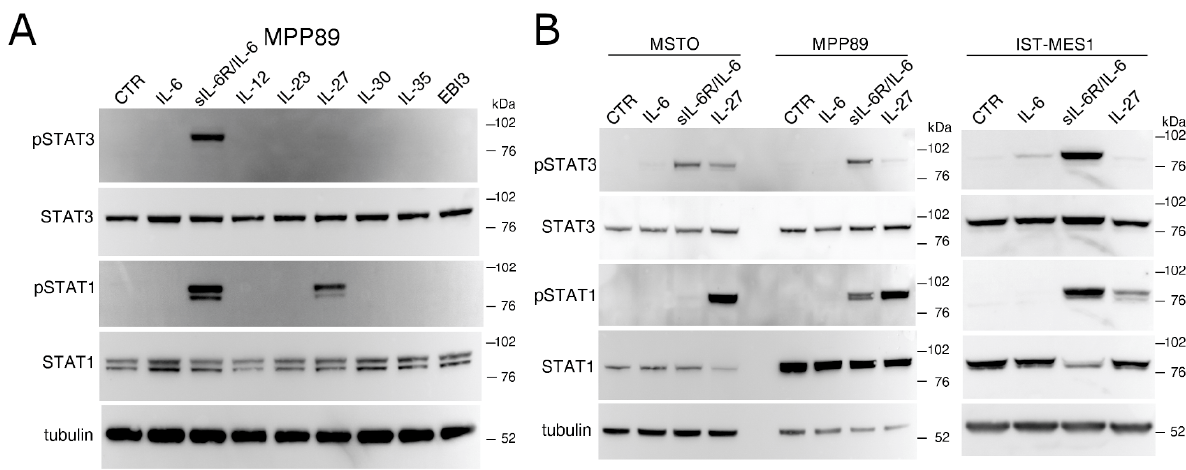
Figure 1. IL-27 predominantly mediates STAT1 phosphorylation in MM cell lines. Western blot analysis of tyrosine phosphorylated (P)-STAT1, P-STAT3, total STAT1 and total STAT3 proteins ( A ) in MPP89 cells stimulated for 20 min with medium (CTR) or the indicated cytokines of the IL-12 family and ( B ) in MSTO, MPP89, and IST-MES1 cells stimulated for 20 min with medium (CTR), IL-6, sIL-6R/IL-6 chimera, and IL-27. Total STATs and α -tubulin were used as loading con- trols.